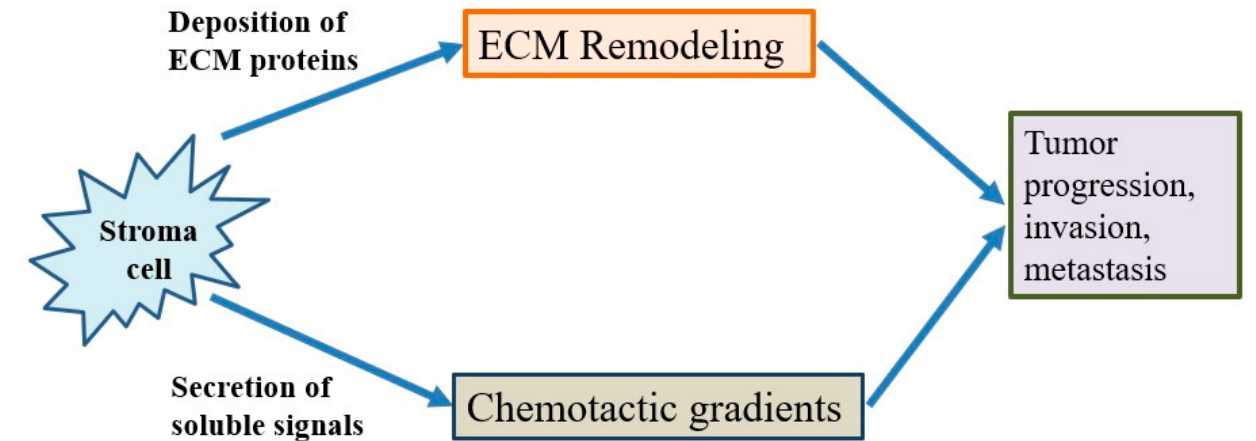
Figure 4. The behavior of cancer cells is affected by their environment. The stromal cells are able to release chemotactic growth factors, and cell-induced mechanical strains are able to rearrange extracellular matrix (ECM) fibers. These factors are correlated with tumor progression, invasion and metastasis. In addition, the tumor cell interacts with fibroblasts to lead to the deposition of new ECM proteins, and physical forces from strains are related with fiber alignment, resulting in persistent migration and invasion of cancer cells.